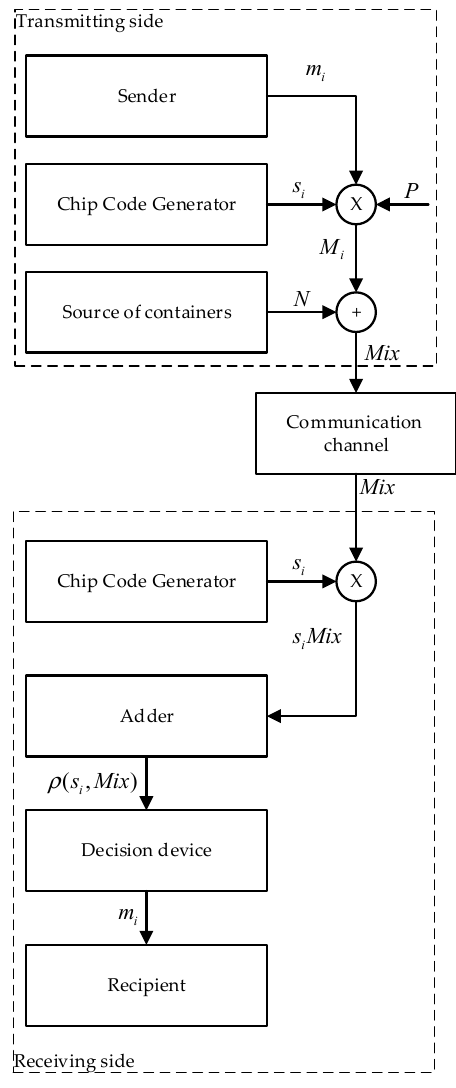
Figure 1. Block diagram of concealment and recovery.